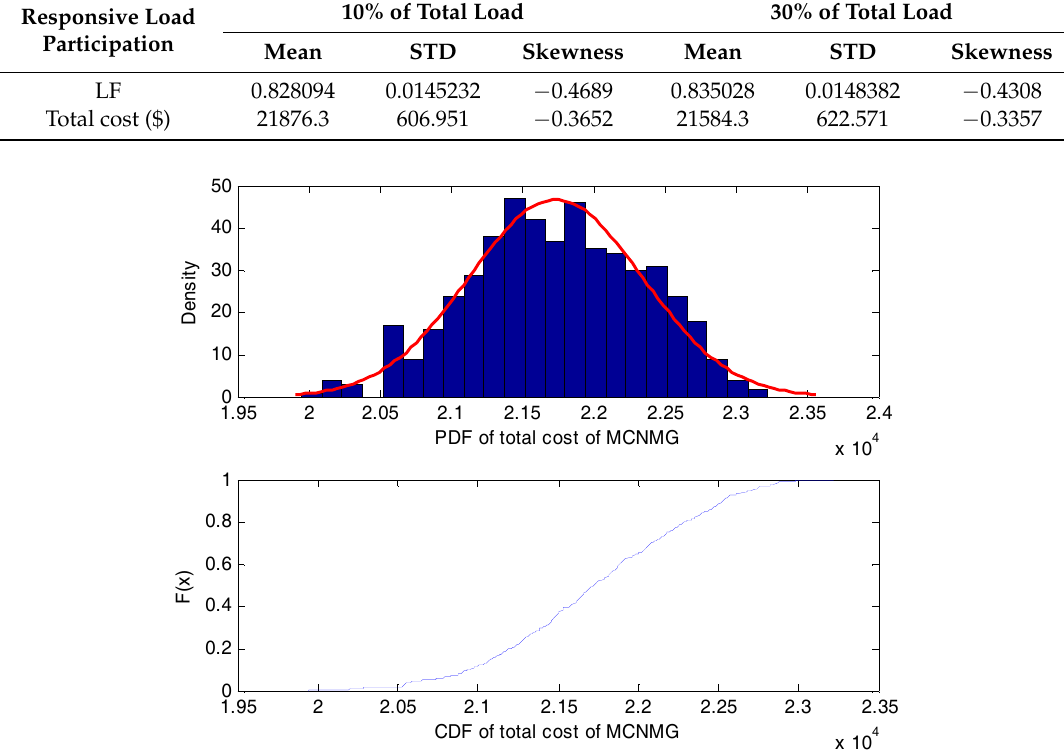
Table 5. Responsive load participation analysis.